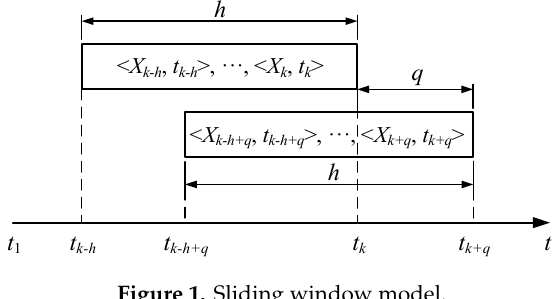
Figure 1. Sliding window model.